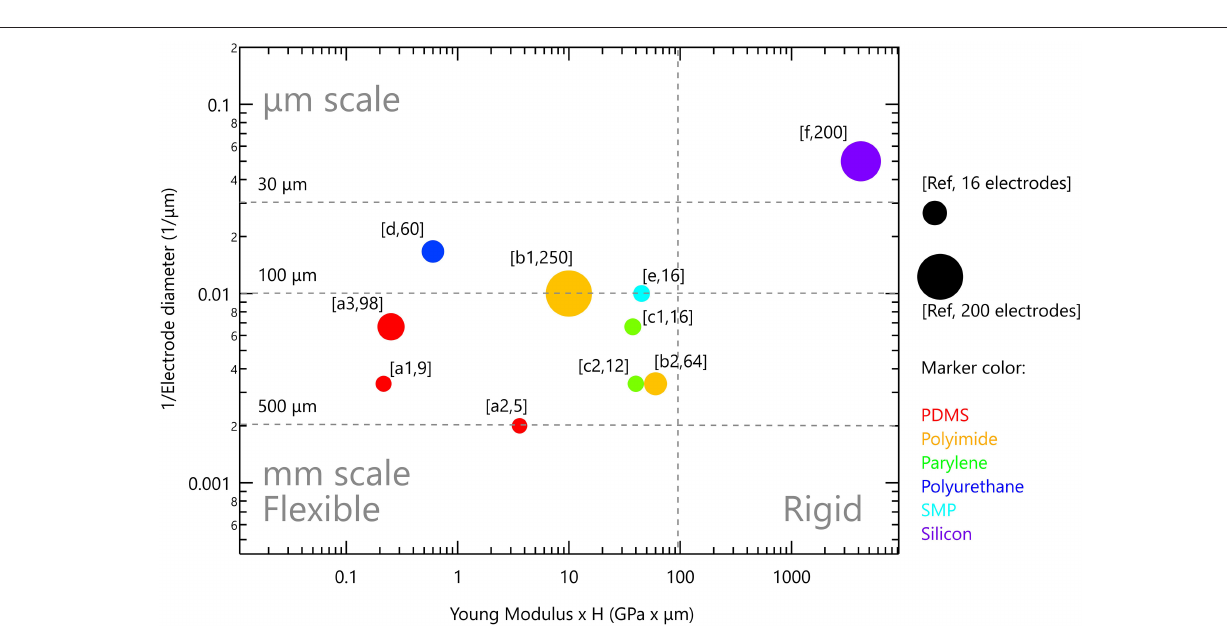
FIGURE 4 | Rigid and flexible neurostimulation devices. Vertical scale is the inverse of electrode diameter; horizontal scale is Young modulus multiplied by device thickness. Marker size reflects the number of electrodes in the device. References: (PDMS) a1 (120), a2 (132), a3 (137); (polyimide) b1 (138), b2 (139); (parylene) c1 (140), c2 (141); (polyurethane) d (142); (SMP) e (143); (silicon) f